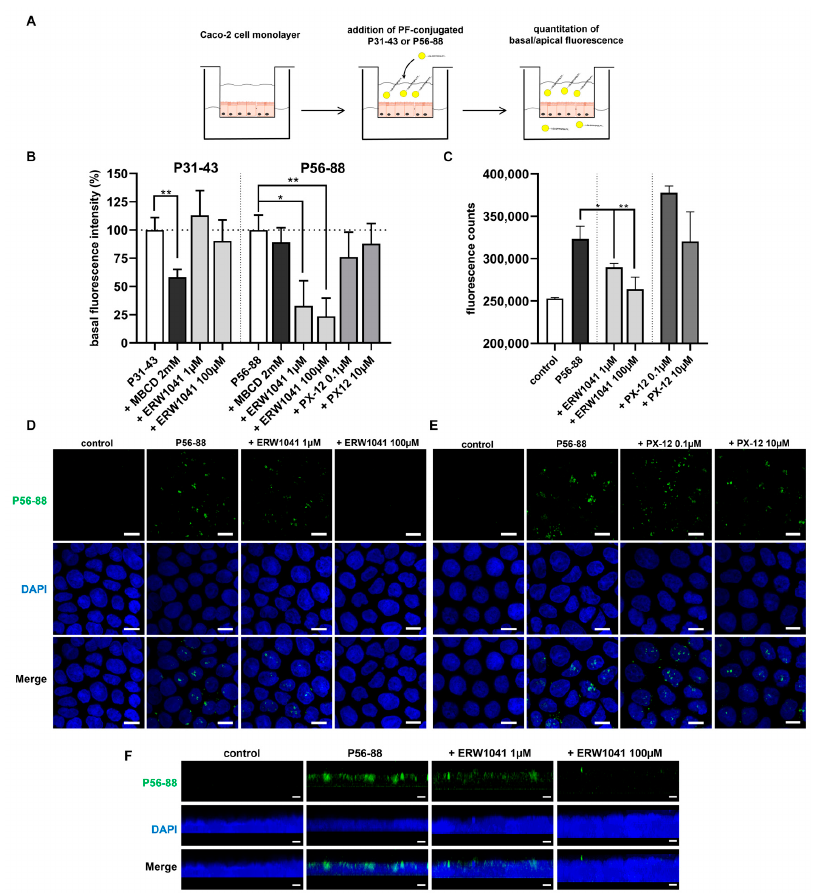
Figure 4. Inhibition of epithelial transport of P56-88 by ERW1041. ( A ) Confluent Caco-2 cell mono- layers were incubated with promofluor-conjugated gliadin peptides P31-43 or P56-88 in the presence of ERW1041 or PX-12. Epithelial translocation of gliadin peptides was quantified by fluorometry of apical and basal supernatant. ( B ) Relative basal fluorescence intensity was quantified after a 3 h incubation of conjugated gliadin peptides in the presence of inhibitors. ERW1041 reduced epi- thelial translocation of P56-88. n = 3 with three technical replicates per experiment. ( C ) Confocal microscopical quantitation of epithelial uptake of P56-88 after 1 h in the presence of ERW1041 and PX-12. n = 3 with three images per experimental condition. ( D , E ) Confocal images of P56-88 uptake by Caco-2 cells in the presence of different amounts of ERW1041 (D) and PX-12 ( E ). ERW1041 inhib- ited epithelial uptake of P56-88 in a dose-dependent manner. ( F ) 3D reconstruction of z-stack im- ages. P56-88 was localized in the supranuclear cell region after 1 h of incubation. ERW1041 inhibited the uptake of P56-88. All data are shown as mean ± SD. Statistical significance was tested with Stu- dent’s t -test. * p < 0.05, ** p < 0.01.